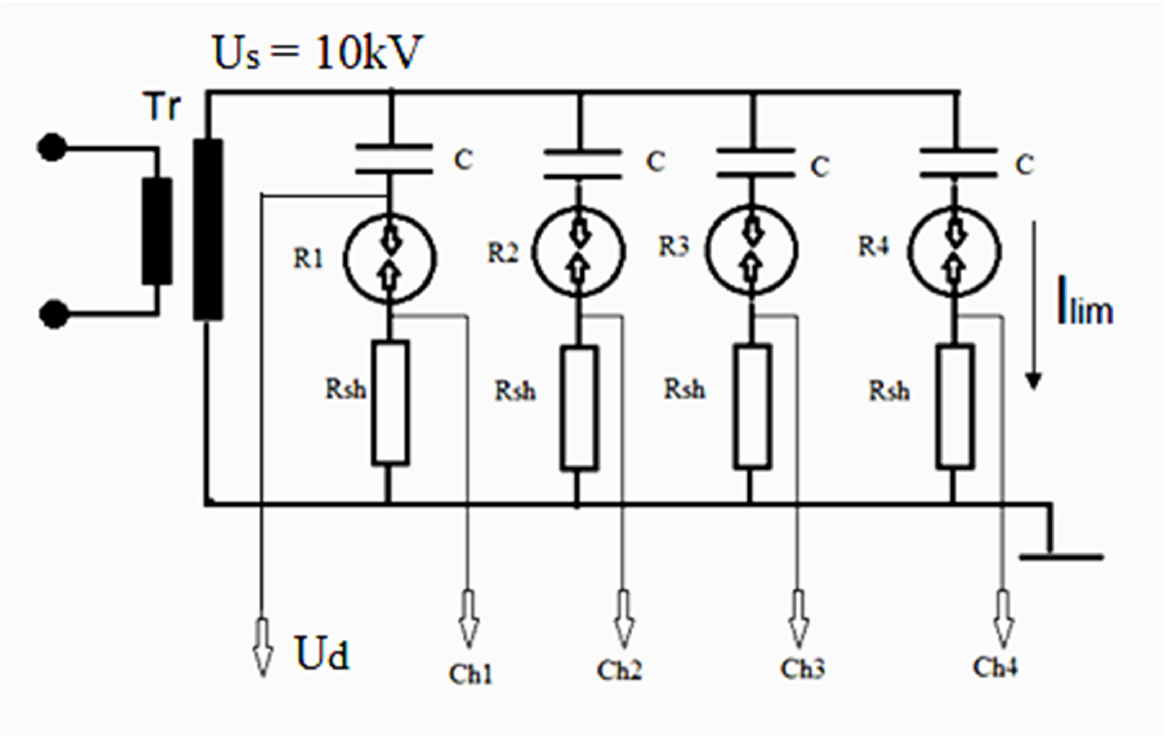
Figure 8. NTP mini-reactor scale-up by capacitive current limitation.